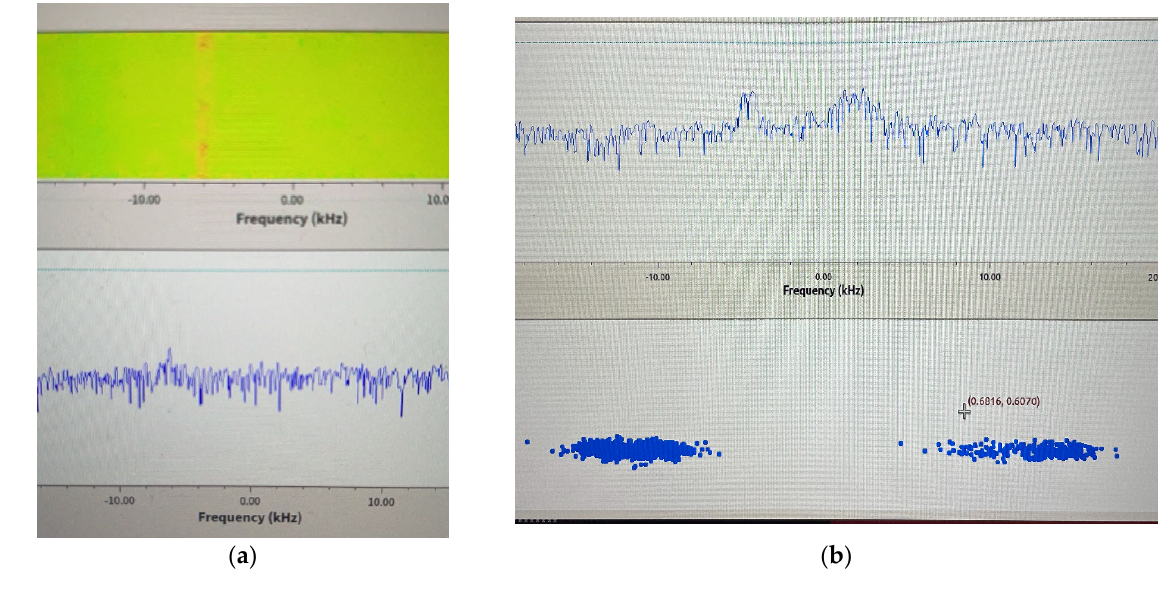
Figure 18. ( a ) GMSK signal spectrum; ( b ) BPSK signal spectrum.